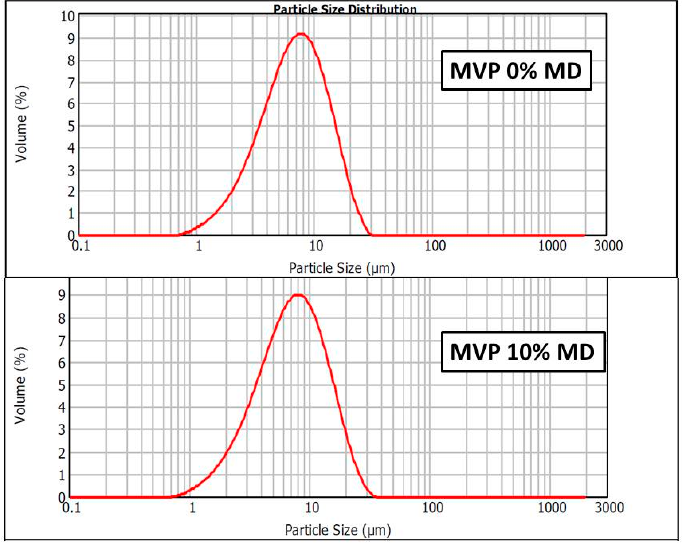
Figure 3. Size distribution of the 0% MD MVP and 10% MD MVP.